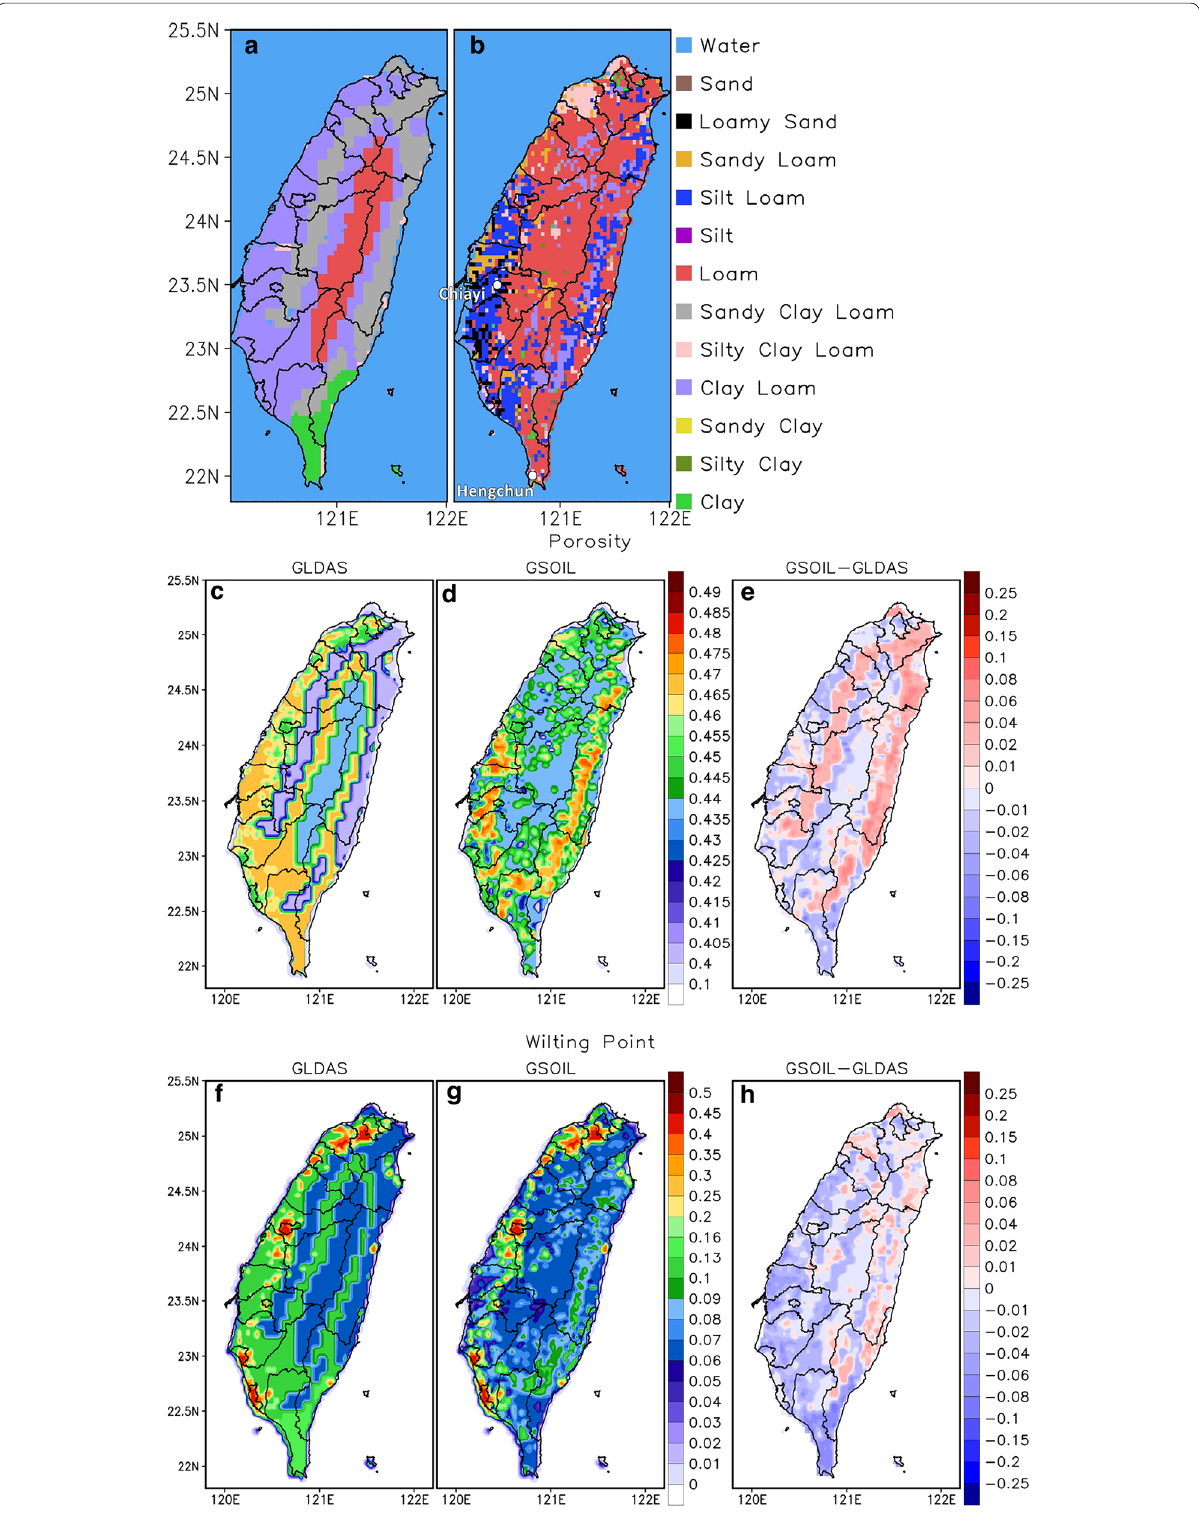
Fig. 3 Distributions of soil textures at 3‑km resolution in Taiwan from a default FAO data sets and b updated soil data. c , d Porosity based on the look‑up table of the default setup and updated soil parameters, respectively; e corresponding difference. f – h Are for the wilting